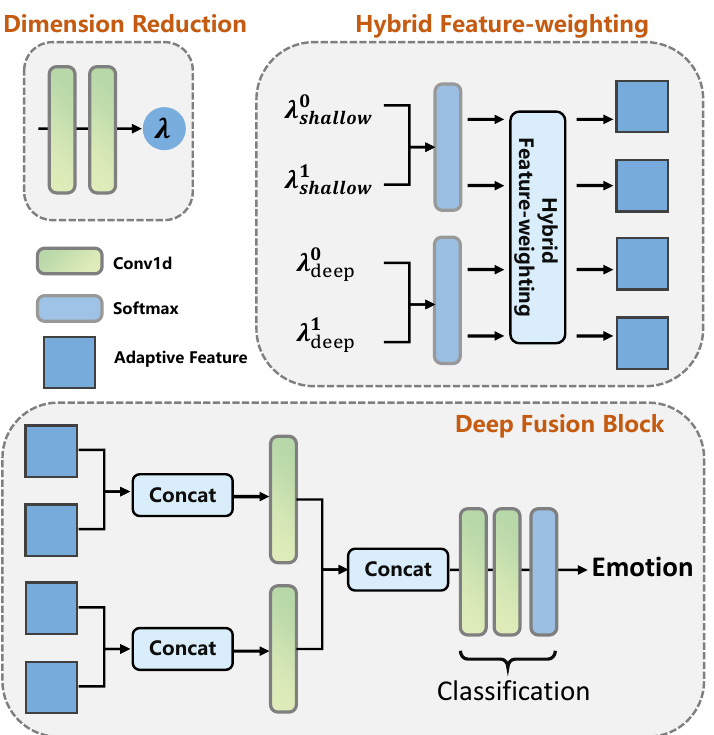
Figure 7. Adaptive-attention and deep fusion blocks for inferring optimal fusion weights and integrating the corresponding emotion adaptive features. The hybrid feature weighting is expressed as Equations (20) and